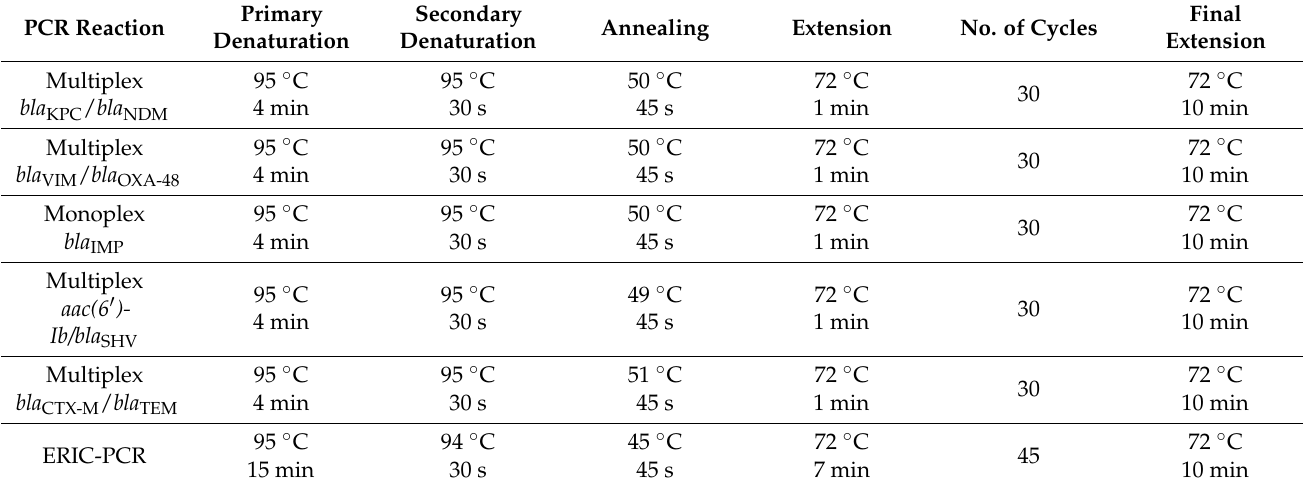
Table 2. Conditions of PCR cycles (thermocycler input